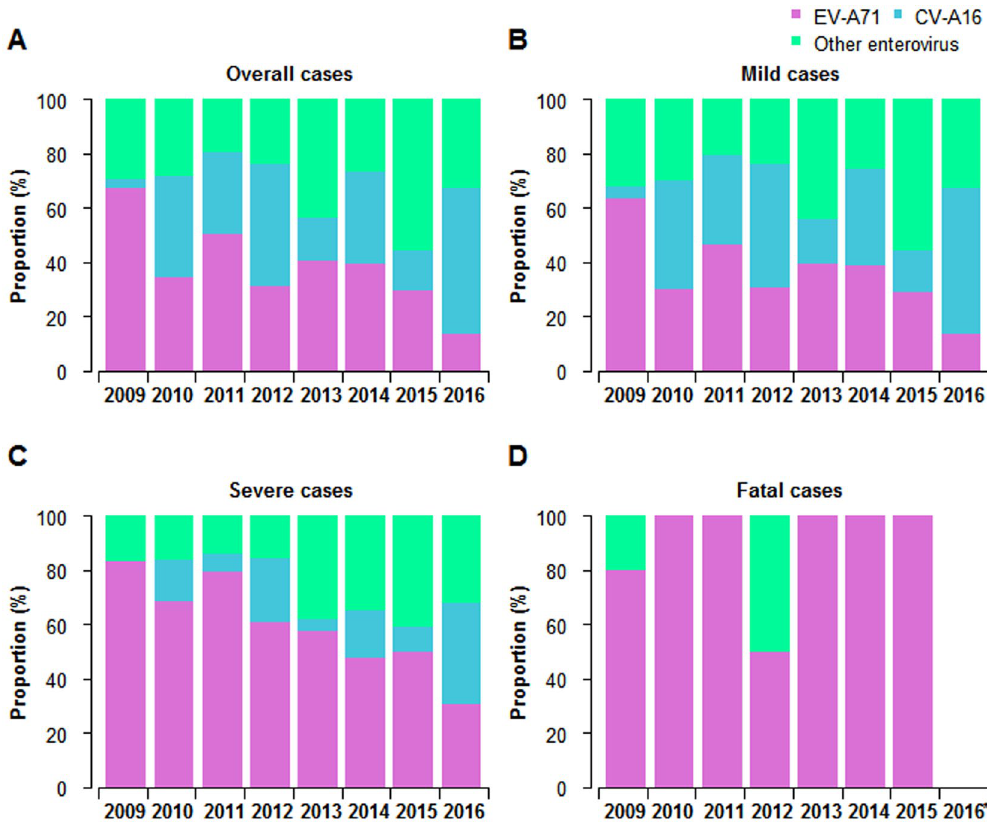
Figure 3. Proportion of enterovirus serotypes in laboratory-confirmed cases of HFMD by clinical severity in Shandong province, 2009–2016. ( A ) Based on all the probable and laboratory-confirmed cases. ( B ) Based on mild cases. ( C ) Based on severe cases. ( D ) Based on fatal